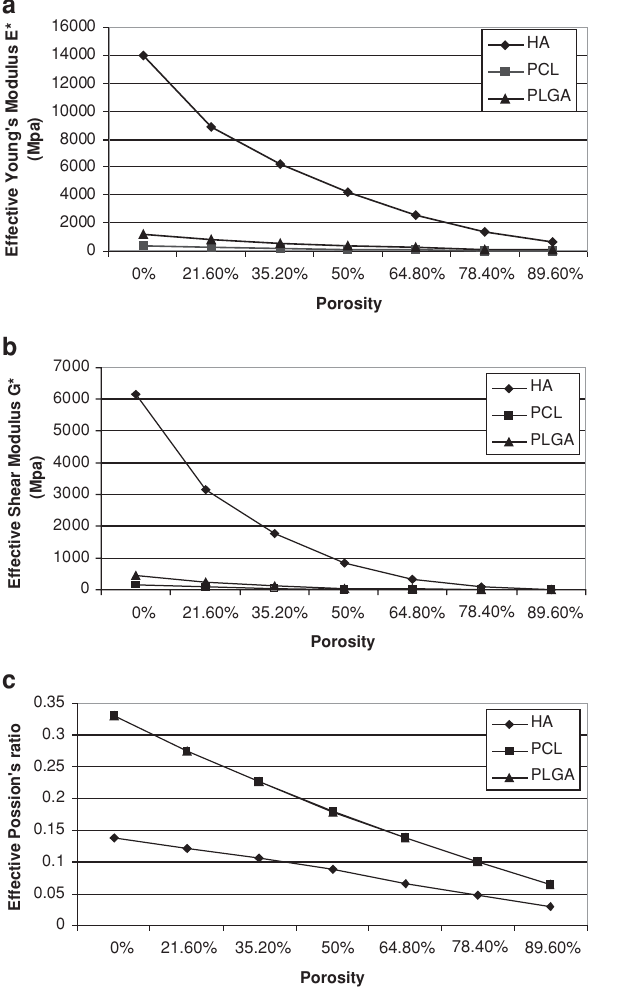
Circular Channel